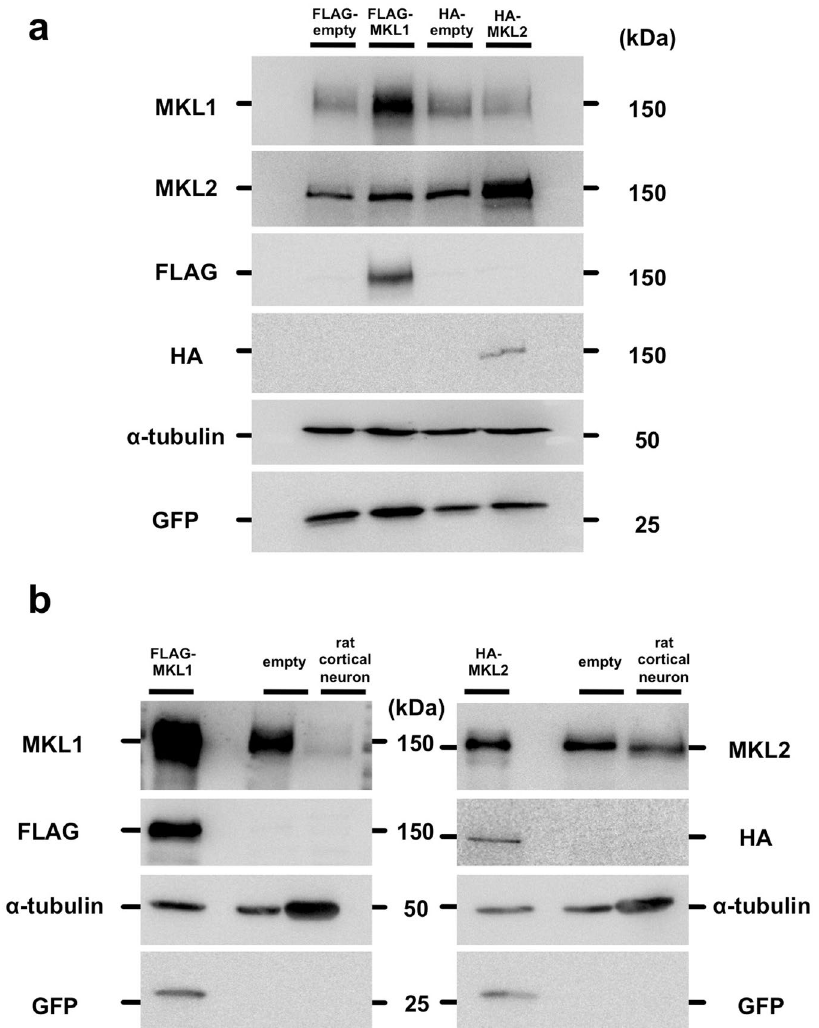
Figure 1. Specific detection of MKL1 and MKL2 by anti-MKL1 and anti-MKL2 antibodies. ( a ) pEGFP-C1 vector and pFLAG-CMV2 vector (FLAG-empty) or pFLAG-CMV2-MKL1 vector (FLAG-MKL1), pCMV-HA vector (HA-empty) or pCMV-HA-MKL2 vector (HA-MKL2) were co-transfected into NIH3T3 cells. Cell lysates were lysed 24 hours after transfection. Anti-MKL1 (MKL1) and anti-MKL2 (MKL2) antibody were used for detection of exogenous and endogenous MKL1 and MKL2, respectively. Anti-FLAG and anti-HA antibodies were used for detection of exogenous MKL1 and MKL2, respectively. Anti- α -tubulin and anti-GFP antibodies were used as internal (loading) controls. ( b ) Detection of endogenous MKL1 and MKL2 in cortical neurons. Left-most lanes: cell lysates from NIH3T3 cells overexpressing FLAG-MKL1 and HA-MKL2. Lane 2: cell lysates from untransfected NIH3T3 cells. Lane 3: cell lysates from rat cortical neurons at 7 days in culture. Full-length blots are presented in Supplementary Figure